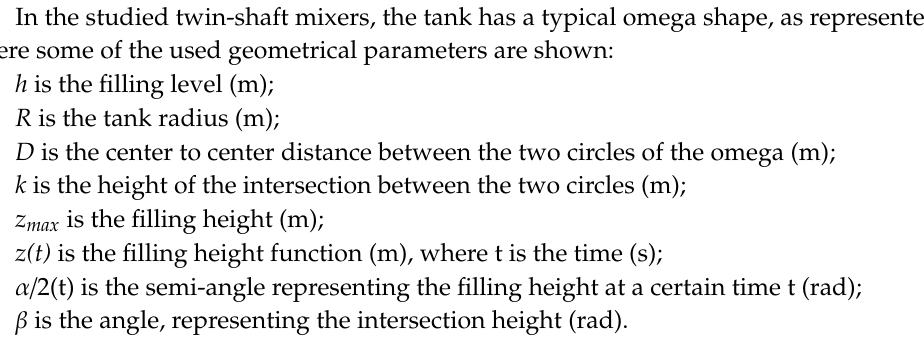
Figure 2. Twin-shaft mixer and mixing components: ( a ) The machine, ( b ) the tank and mixing components: 1 : Scraper, 2 : Blade, 3 : Arm and connection, 4 : Shaft.